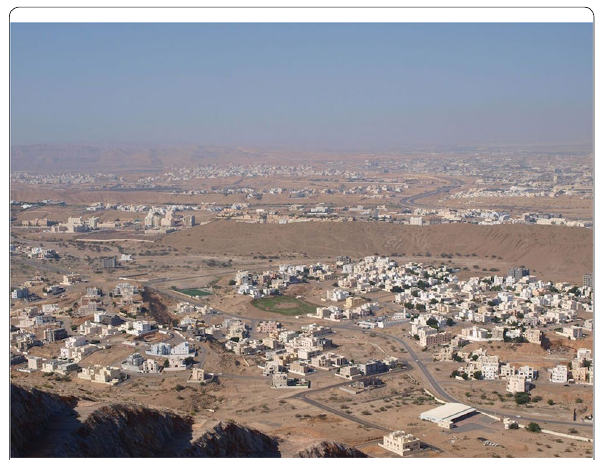
Fig. 1 Photo of new residential neighbourhood in Muscat Capital Area with plot allocated by the Omani lottery in state of partial development. Source the authors (2016)